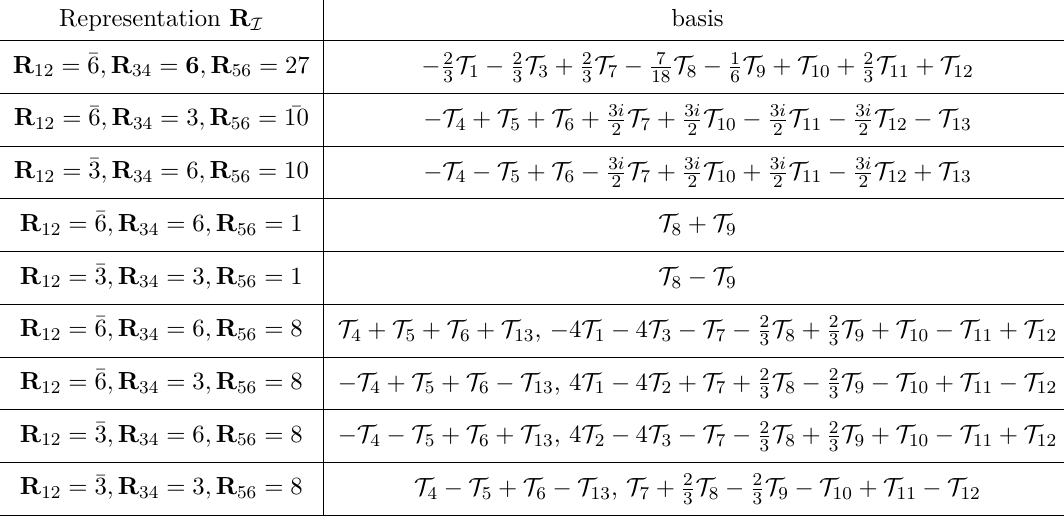
Table 10 . Gauge partial-wave basis of SU(3) particles { 3 , 3 , ¯3 , ¯3 , 8 , 8 } of partition { 12 | 34 | 56 } .